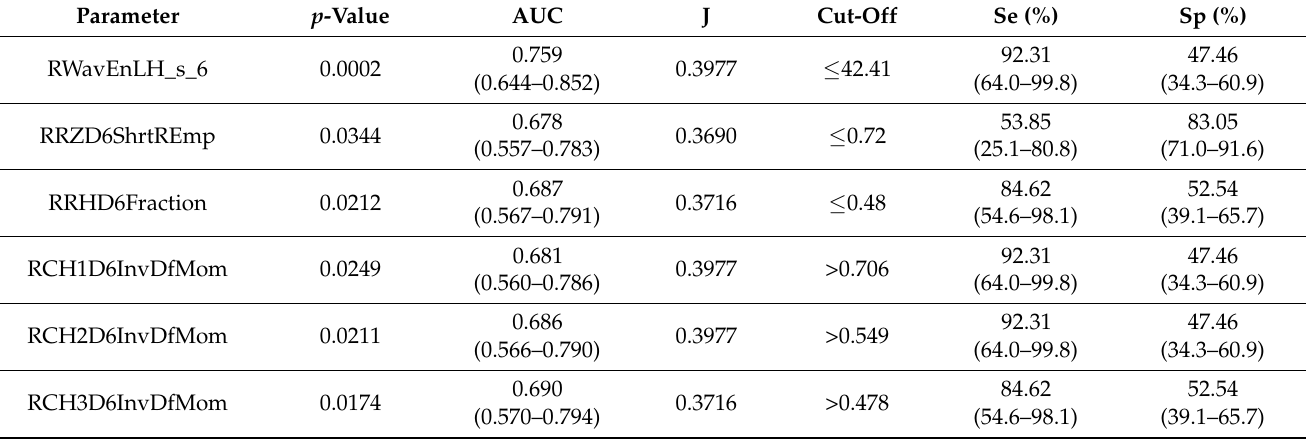
Table 5. Parameters not independently associated with the HER2 status. Between the brackets are the values corresponding to the 95% confidence interval.